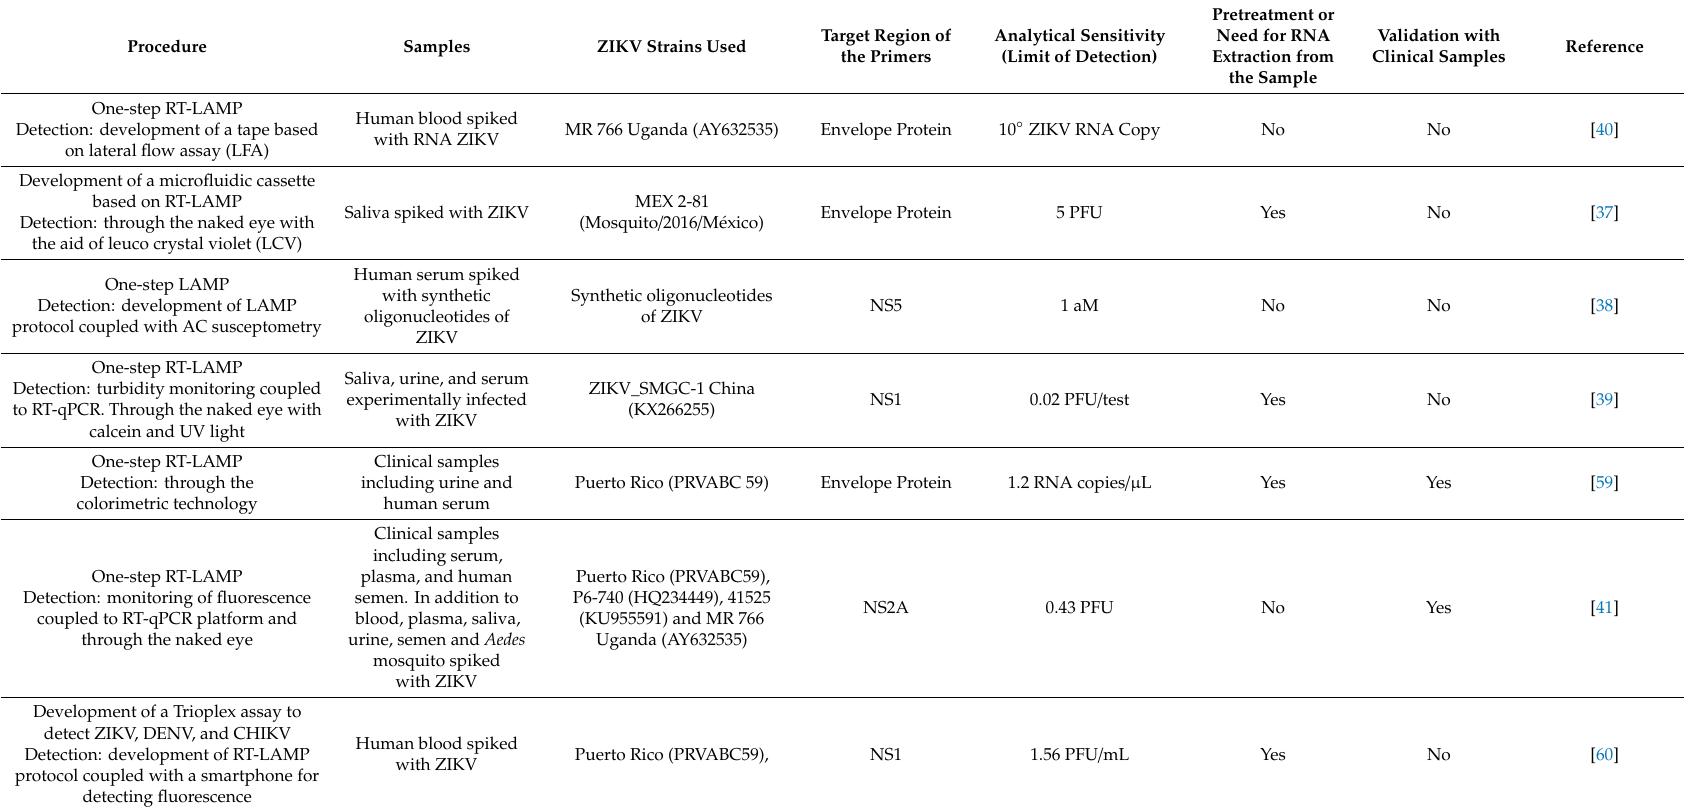
Table 1. LAMP platforms for Zika virus (ZIKV)